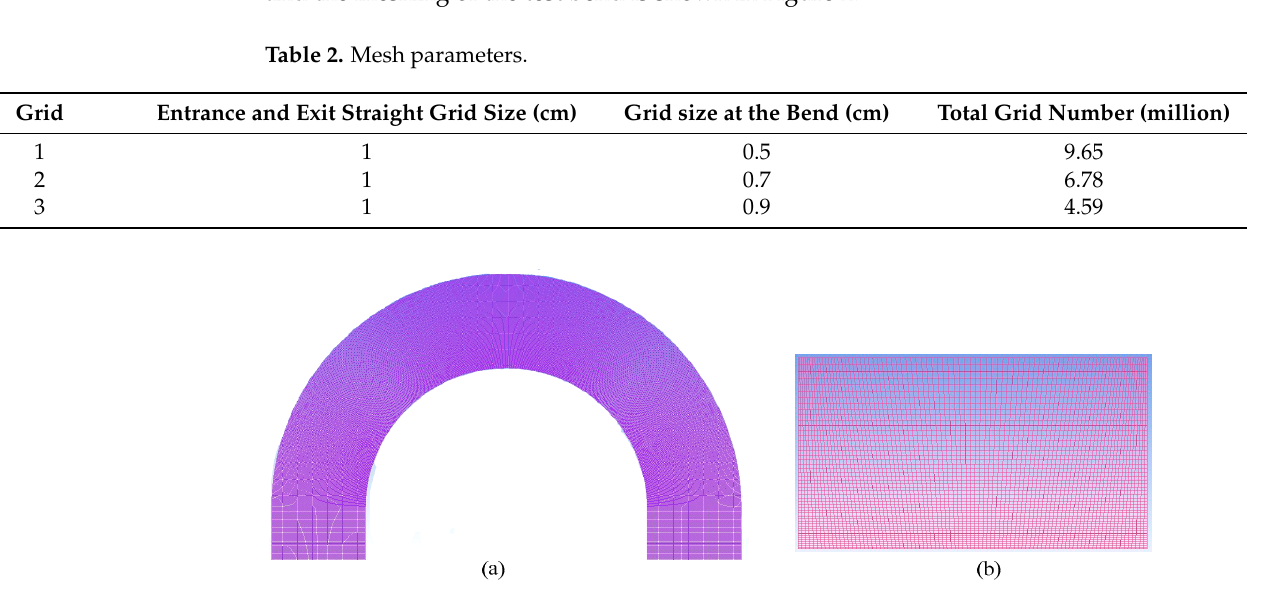
Figure 2. Test curve grid division for Mesh division at the band ( a ) and grid division cross section ( b ).